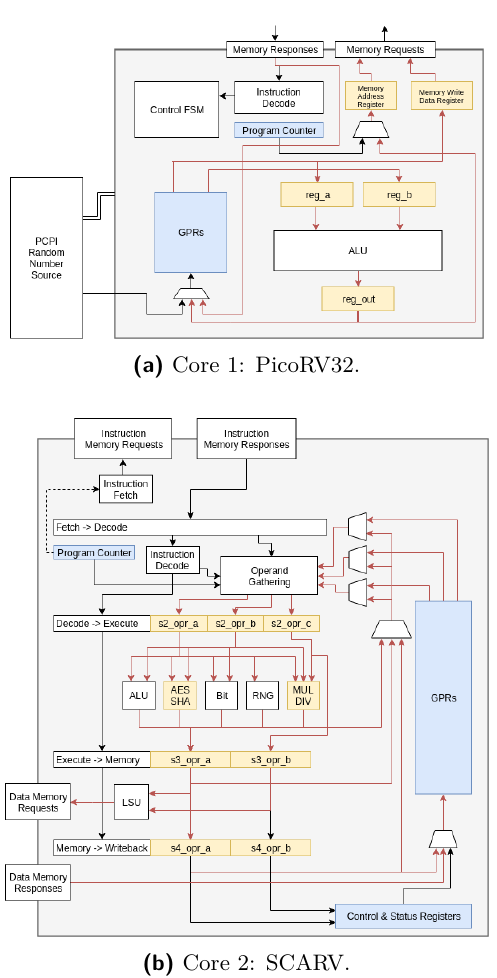
Figure 2: A block diagram of each core: architectural resources are highlighted in blue, micro-architectural resources are highlighted in yellow, and data-paths that may carry security critical data (from a side-channel perspective) are highlighted in red.